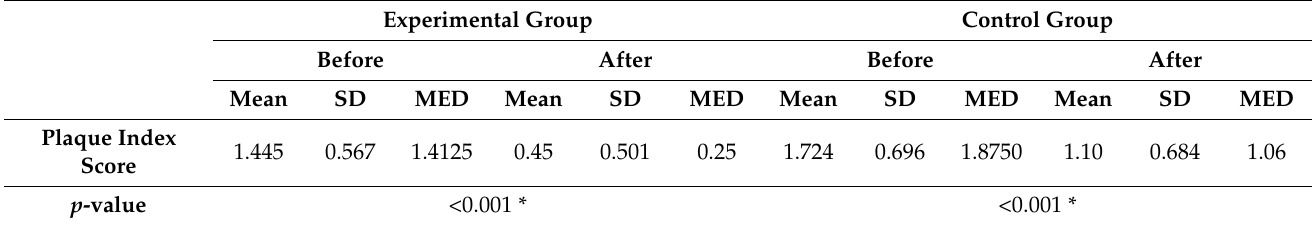
Table 4. Comparison Between Oral Hygiene Status Before and After the use of the Dental Visual Aids Within each